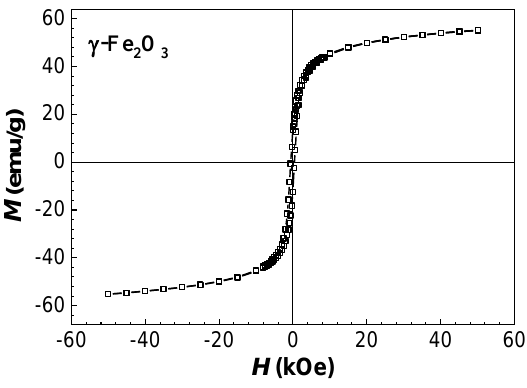
Figure 5. Magnetic properties of iron oxide nanoparticles.